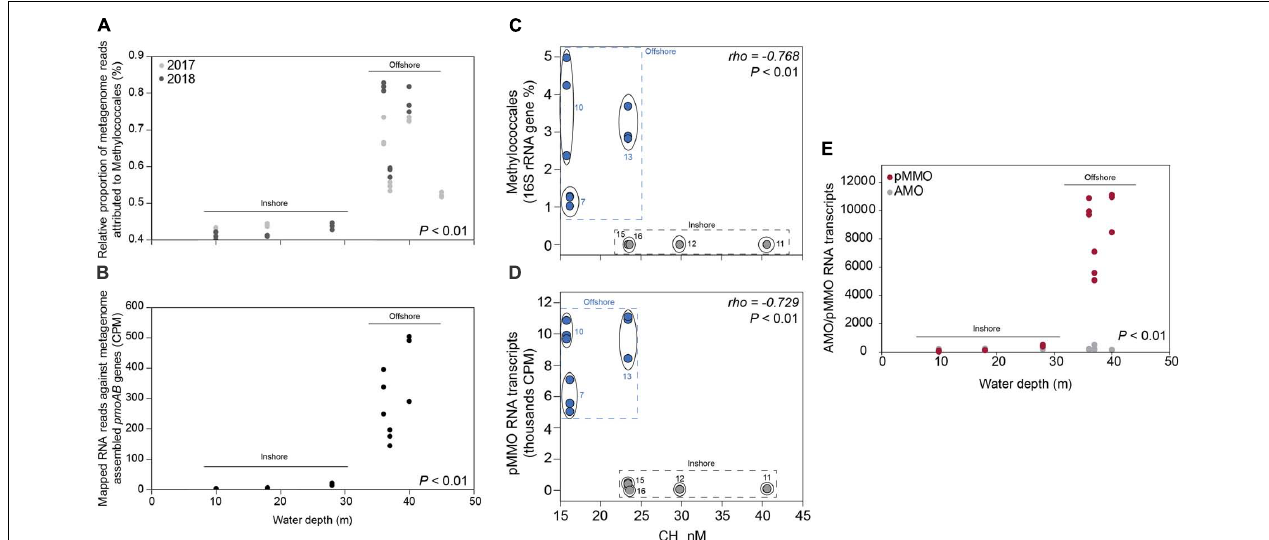
FIGURE 3 | (A) The relative proportion of reads ( y -axis%) attributed to the methanotrophic Gammaproteobacteria order Methylococcales compared to the whole prokaryotic community. The data was based on all metagenomic sequences classified against the NCBI RefSeq genome database. The x -axis shows the water depth (m), each circle represents one sediment core, and the colors denotes the sampling year (light gray as 2017, and dark gray as 2018). The water depth for the inshore stations are: 10 m (stations 12 and 16), 18 m (11), 28 m (15); and offshore stations: 36 m (10), 37 m (7), 40 m (13), and 45 m (5). (B) Mapped RNA reads (2018 RNA data) against metagenome assembled pmoAB genes ( > 500 bp long, 2018 DNA data). The data shows normalized sequence counts (counts per million sequences; CPM values). The x -axis shows the water depth (m), and each circle represents one sediment core. (C) The relative abundance of the methanotrophic Gammaproteobacteria order Methylococcales in the 0–2 cm sediment surface ( y -axis, n = 3 per station) and measured CH 4 in the water column ( x -axis, n = 1 per station). The relative abundance of Methylococcales shown is based 16S rRNA gene sequences extracted from the 2018 DNA data, while CH 4 was measured in the water surface (0.5–1.0 m water depth). (D) RNA transcripts classified as pMMO against the UniProtKB/Swiss-Prot database (based on classifying all paired-end merged RNA reads). Values shown are normalized sequence counts (CPM). Blue filled circles denote stations further away from the coast, and the gray circles show the sampling stations for each cluster of data points. (E) RNA sequences annotated to the InterPro AMO/pMMO family was classified against the UniProtKB/Swiss-Prot database and compared to the water depth (m) of the stations ( x -axis). CPM values shown are based on all proteins classified against the InterPro database ( y -axis). Each circle in the graph denotes RNA transcripts derived from the 0–2 sediment surface from individual sediment cores. Dark red circles denote pMMO and light gray circles denote AMO. The P -values indicate the statistical significance (Kruskal–Wallis tests) for Methylococcales, pmoAB , and pMMO between inshore and offshore (A,B,E) , and alongside rho values that show results from Spearman correlations (C,D)